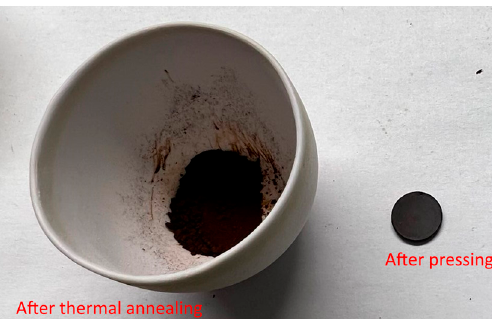
Figure 1. Image of perovskites before and after the pressing